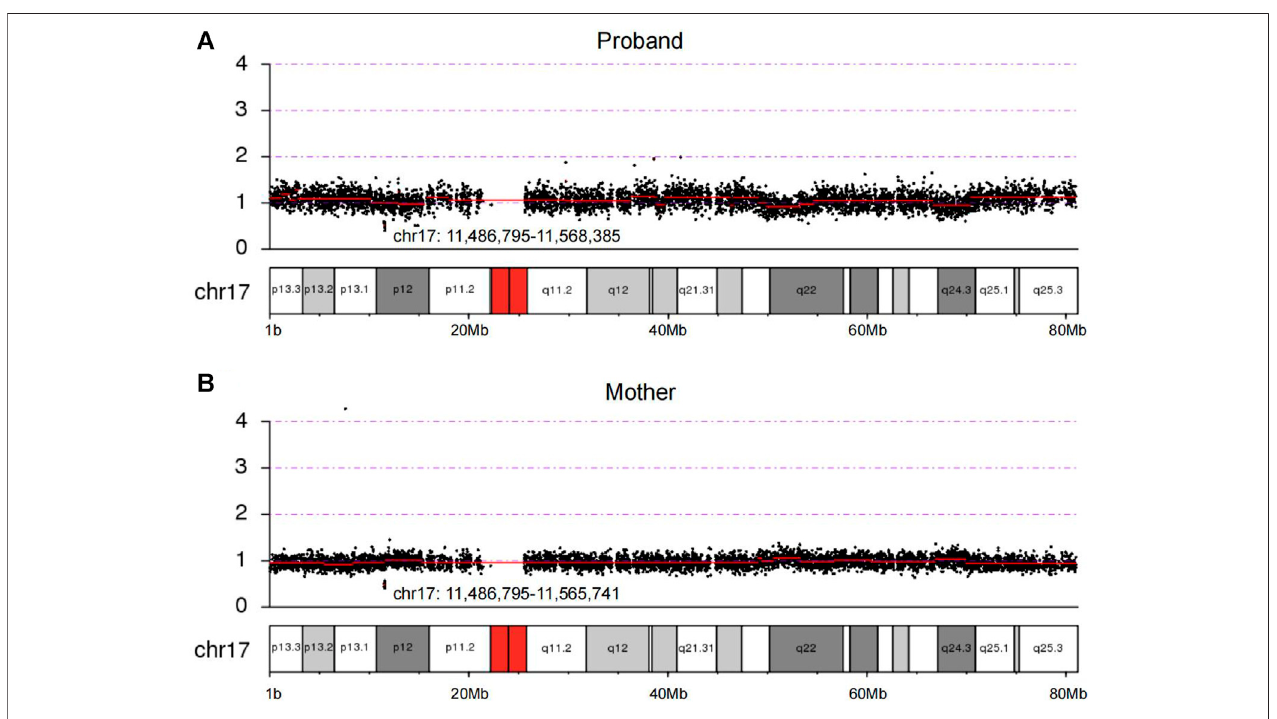
FIGURE2| Thelossofheterozygosityat17p12intheprobandandthemotherweredetectedbyCNV-seq. (A) Copynumberofchromosome17intheprobandby sequencing. (B) Copy number of chromosome 17 in the proband ’ s mother by sequencing. The chr17:11,486,795 – 11,568,385 and chr17:11,486,795 – 11,565,741 showed in (A) and (B) were regions of deletion in the proband and her mother,